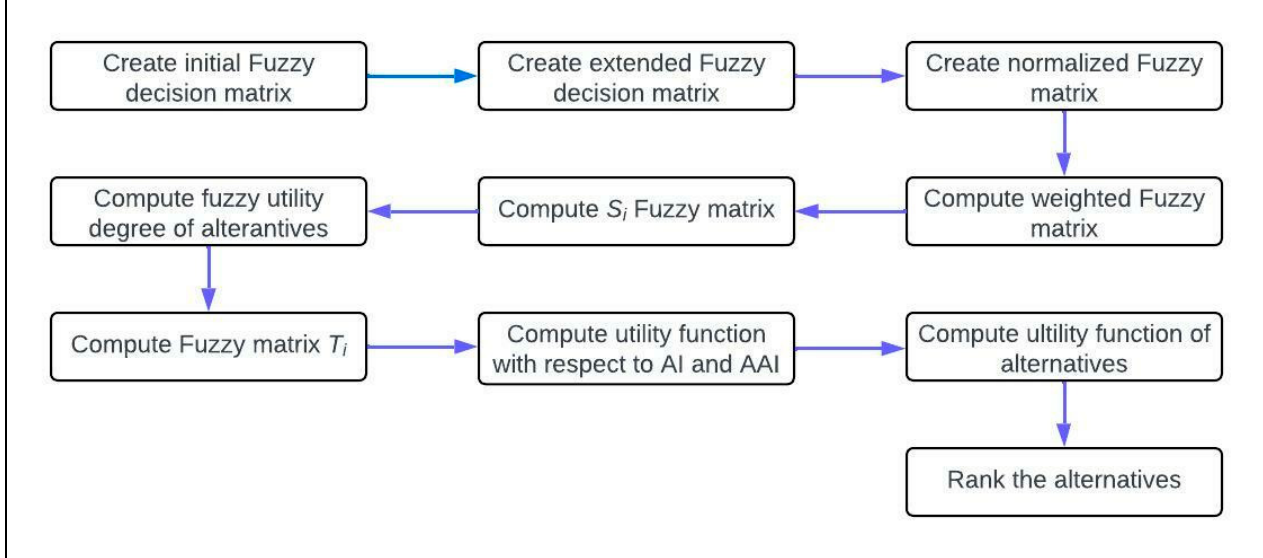
Figure 1. Flowchart of Fuzzy MARCOS method.